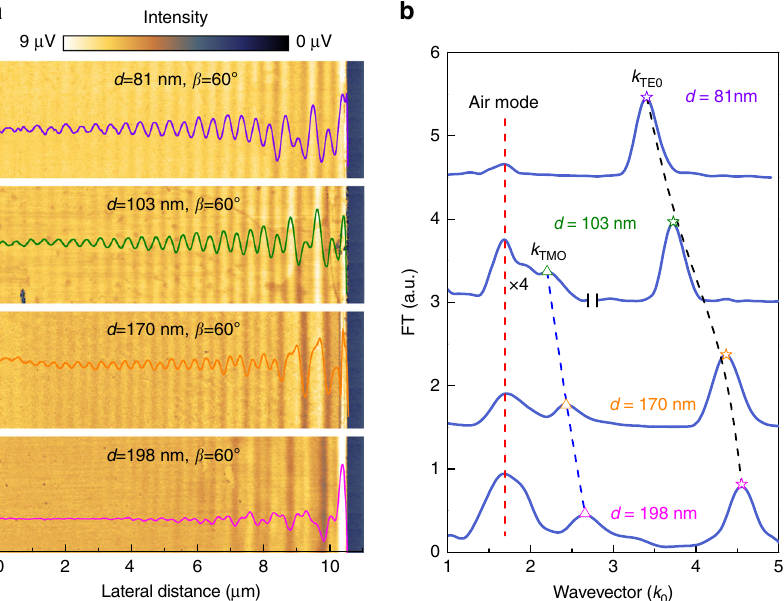
Fig. 2 Experimental results. a Near- fi eld images and real-space fringe pro fi les of MoS 2 samples with different thicknesses. b Momentum – space spectra of fringe pro fi les in a . In the experiments, the MoS 2 nano fl akes are all placed in the same orientation as in Fig. 1a. The low-frequency peaks in b showing no thickness dependence are the trivial air modes. Note that in b the left part of the second spectrum ( d = 103 nm) is multiplied by four